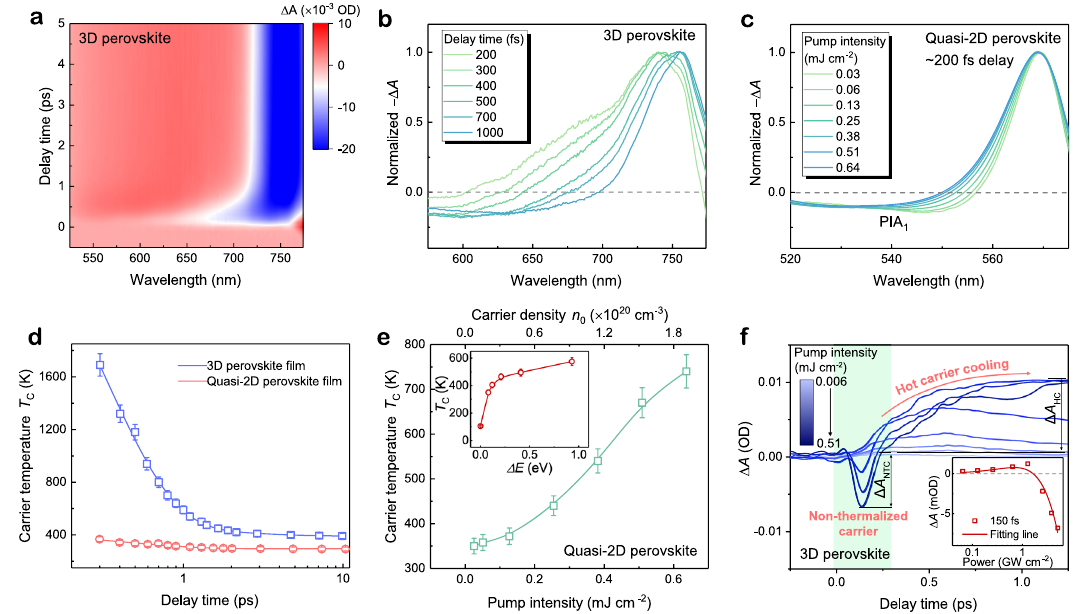
Fig. 4 | Comparison of hot-carrier effects. a Pseudocolour representation and b Normalized TA spectra at different delay times of 3D bulk perovskite fi lm. The pump laser pulse is 480nm (2.6eV) with excitation fl uence around 0.13mJ cm − 2 . c NormalizedTAspectraofquasi-2Dperovskite fi lmat200fsdelayunderdifferent excitation intensities. The pump laser wavelength is 400nm (3.1eV). Herein, the energy of the photon _ ω used to excite 3D and quasi-2D perovskites is 2.6eV and 3.1eV, respectively, to ensure an equal excess energy (0.9eV) of initially injected carriers. d Time-dependent hot carrier temperatures of 3D and quasi-2D per- ovskites,respectively.Thepump fl uenceismaintainedat0.13mJcm − 2 . e Initialhot-